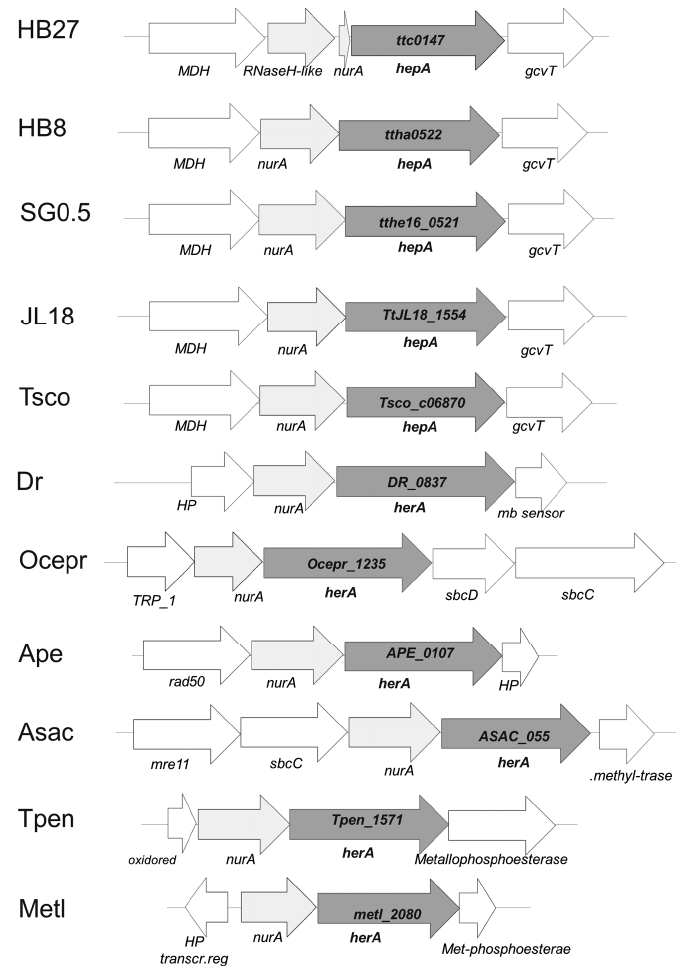
Figure 1. Genomic context of hepA homologs. Synteny of the cluster in which the common homolog of Hep A is found in T. thermophilus HB27 ( ttc0147 ), T. thermophilus HB8 ( ttha0522 ), T. thermophilus SG0.5JP16-17 ( tthe16_0521 ), T. thermophilus JL18 ( TtJL18_1554 ) and T. scotoductus (Tsco_c06870) , Deinoccoccus radiodurans (DR_0837) , Oceanithermus profundus (Ocepr_1235) , and the archaea Aeropyrum pernix (APE_0107) , Acidolobus saccharovorans (ASAC_055) , Thermofilum pendens (Tpen_1571) , and Methanobacteirum lacus